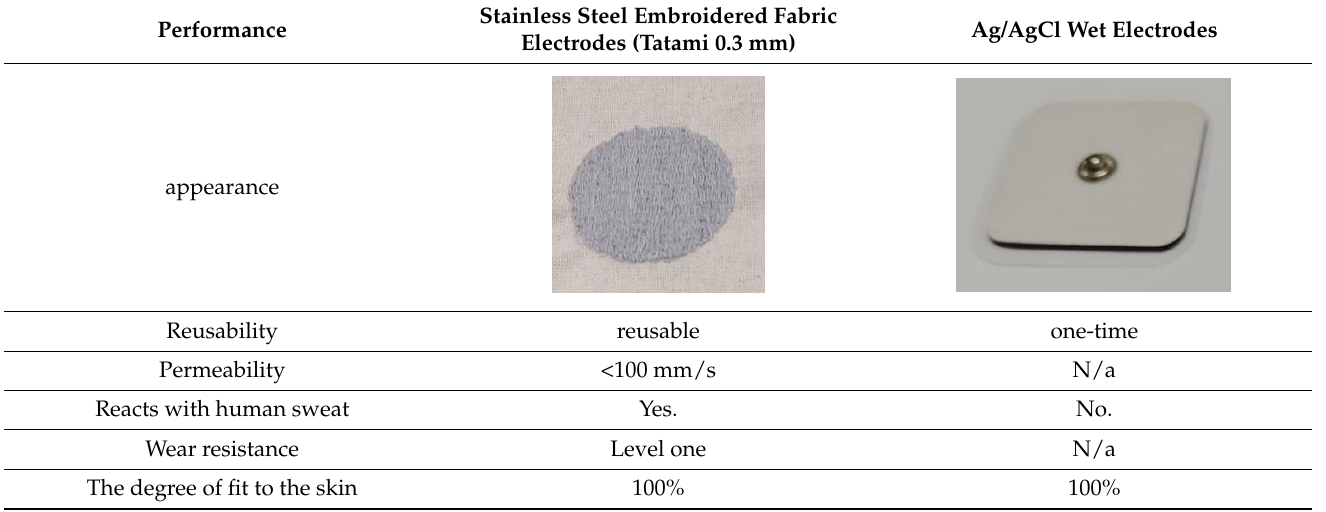
Table 2. Comparison between stainless steel yarn embroidery fabric electrode and traditional Ag/AgCl wet electrode.